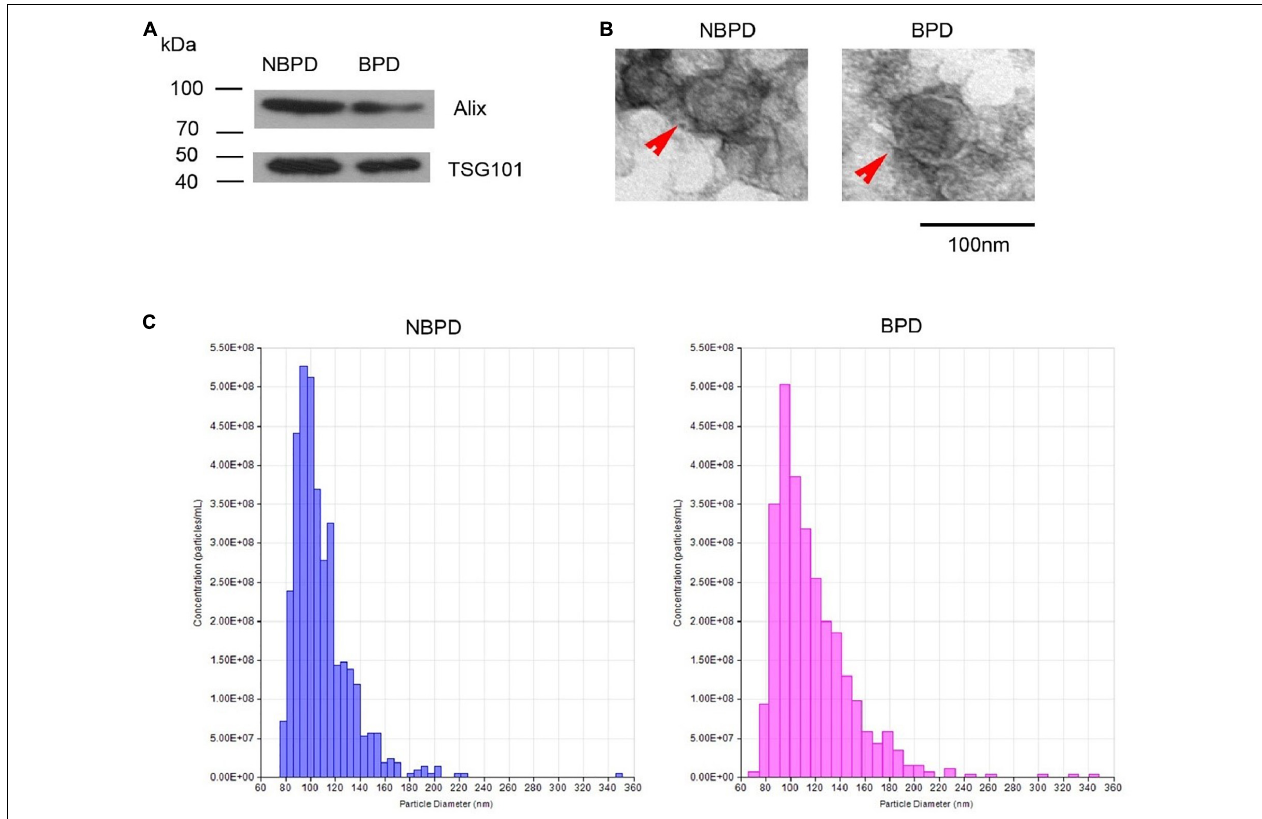
FIGURE 1 | Exosome identification. (A) Expression of exosomal markers was determined by Western blotting. (B) Representative images showing morphology of exosome (red arrow) under transmission electron microscopy. (C) Nanoparticle size distribution measured by NTA. n =